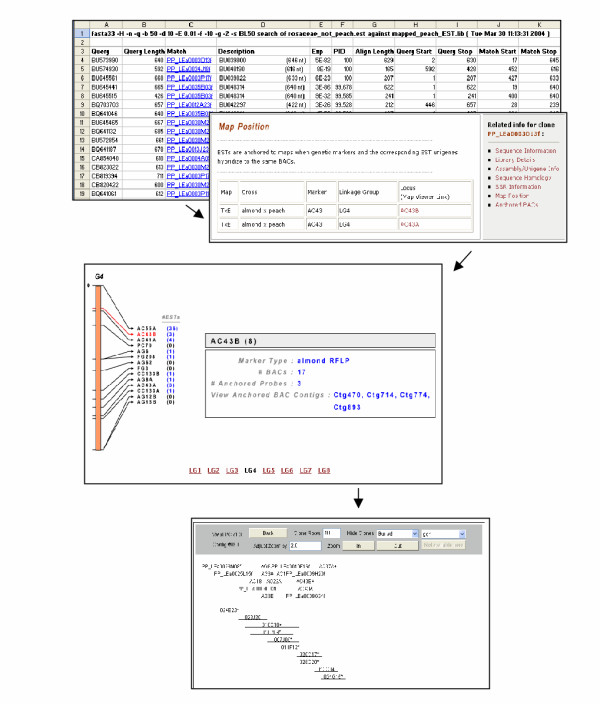
Case Study: Hyperlink to map viewers from the sequence similarity search result. This figure shows snapshots of hyperlinked pages to illustrate that users can obtain putative genetic and physical map positions of the query sequences when the sequences have match to mapped peach ESTs. A. A spread sheet with sequence similarity search results B. EST detail page with map position C. Map Viewer D. WebFPC.